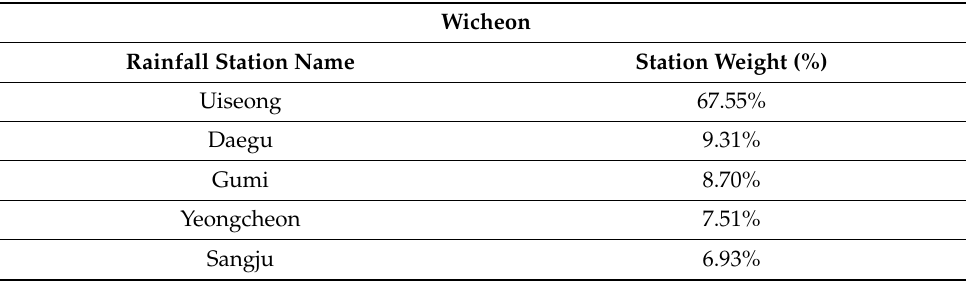
Figure 2. Wicheon Thiessen Polygon. Table 1. Theissen weight for each rainfall station in Wicheon